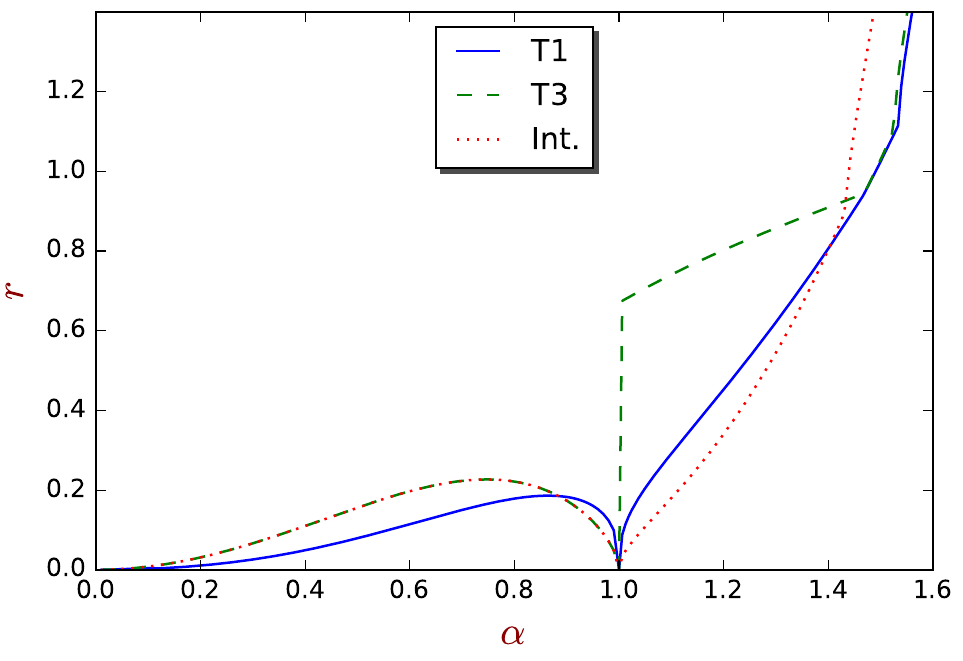
Fig. 3 Spectral radius of the AM3 methods for T1, T3 and interpolation